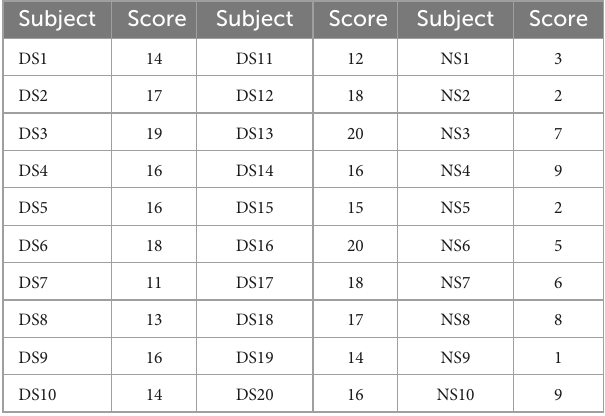
TABLE 1 Pittsburgh Sleep Quality Index